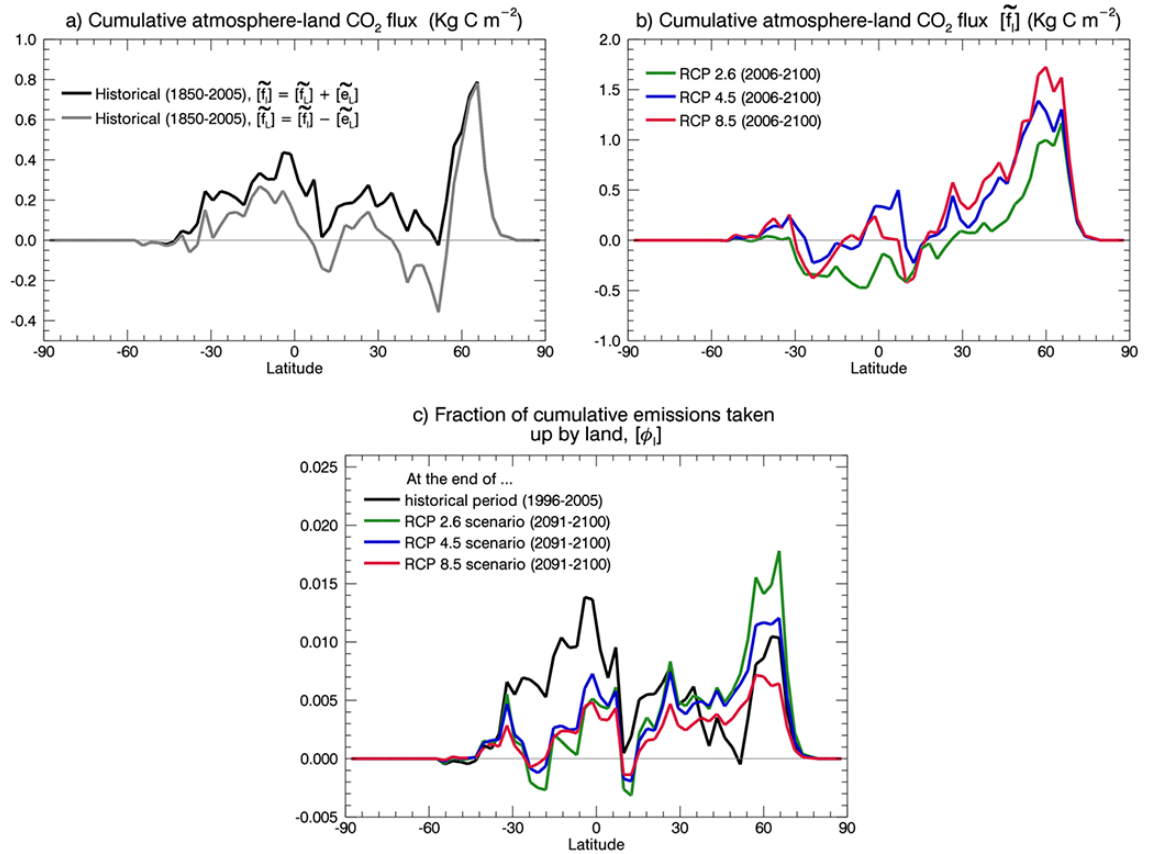
Figure 3. The latitudinal distribution of the cumulative atmosphere–land CO 2 fluxes for the historical 1850–2005 (a) and future 2006–2100 (b) periods for the three RCP scenarios. (c) Plots [ ϕ l ] the latitudinal contribution of ˜ f l to 8 l the global fraction of cumulative emissions taken up by land over the historical period and over the 21st century for the three RCP